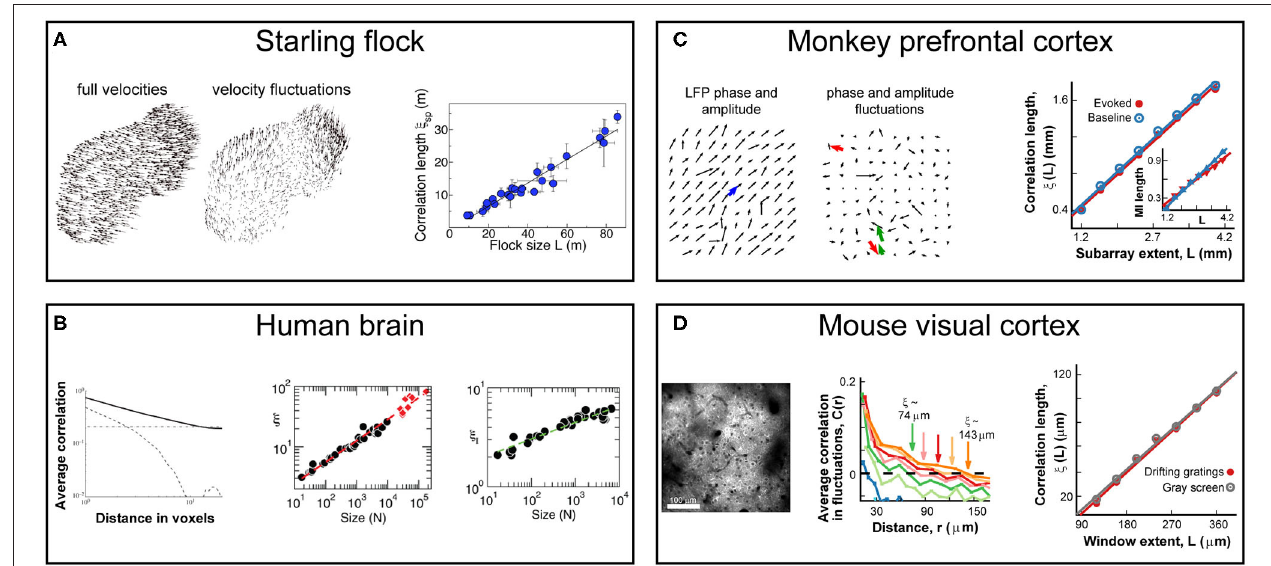
FIGURE 1 | Scale-free growths in correlations length is observed in bird flocks and the mammalian brain at different scales and using different recording techniques. (A) Correlations in the velocity fluctuations of pairs of starlings in flocks of different sizes. Fluctuations are obtained by subtracting from each bird’s velocity vector ( left ) the center-of-mass velocity of the flock ( middle ). Correlation length, defined as the distance at which correlations of the fluctuations reaches zero, scales linearly with flock size ( right ) in line with expectations from critical dynamics. Adapted from (Cavagna et al., 2010). (B) Correlations obtained from blood oxygenated level dependent (BOLD) signals using fMRI to measure ongoing neuronal activity of the human brain. Left : Average correlation between voxel pairs drops with distance between voxels as a power law ( solid line ), while phantom data drops exponentially ( dashed line ) and spatially shuffled data is constant ( dotted line ). Adapted from (Expert et al., 2011) Middle : Correlation length, ξ , from fluctuations in BOLD data scales linearly with the size of the brain area observed ( black circles ) or when pooling areas together ( red diamonds ). Adapted from Fraiman and Chialvo (2012). Right : Mutual information between voxel pairs decays with pair distance, allowing for the definition of “mutual information length,” ξ I , in analogy to correlation length. ξ I scales linearly with the size of the brain area observed ( black circles ). Adapted from Fraiman and Chialvo (2012). (C) Correlations in the fluctuations of LFP amplitudes from prefrontal cortex in nonhuman primates during a working-memory task using high-density microelectrode arrays. Left/middle : LFP vectors depicting phase and amplitude on the array without/with subtraction of the population average ( blue arrow , left ) in analogy to velocity distributions in flock data. Right : Correlation length scales linearly with (sub)array size for both ongoing ( blue ) and evoked ( red ) data. Adapted from Ribeiro et al. (2020). Inset : Mutual information length scales linearly with (sub)array size for both ongoing ( blue ) and evoked ( red ) data. (D) Correlations in the fluctuations of neuronal activity from primary visual cortex in mice during visual stimulation using 2-photon imaging. Left : Example field-of-view showing cells used for the analysis. Middle : Average correlation of activity fluctuations between pairs of neurons decays with distance as well as with the size of the observed window ( colors ). Right : Correlation length scales linearly with observed window size for both gray screen ( gray ) or drifting gradings ( red ). Adapted from Ribeiro et al.